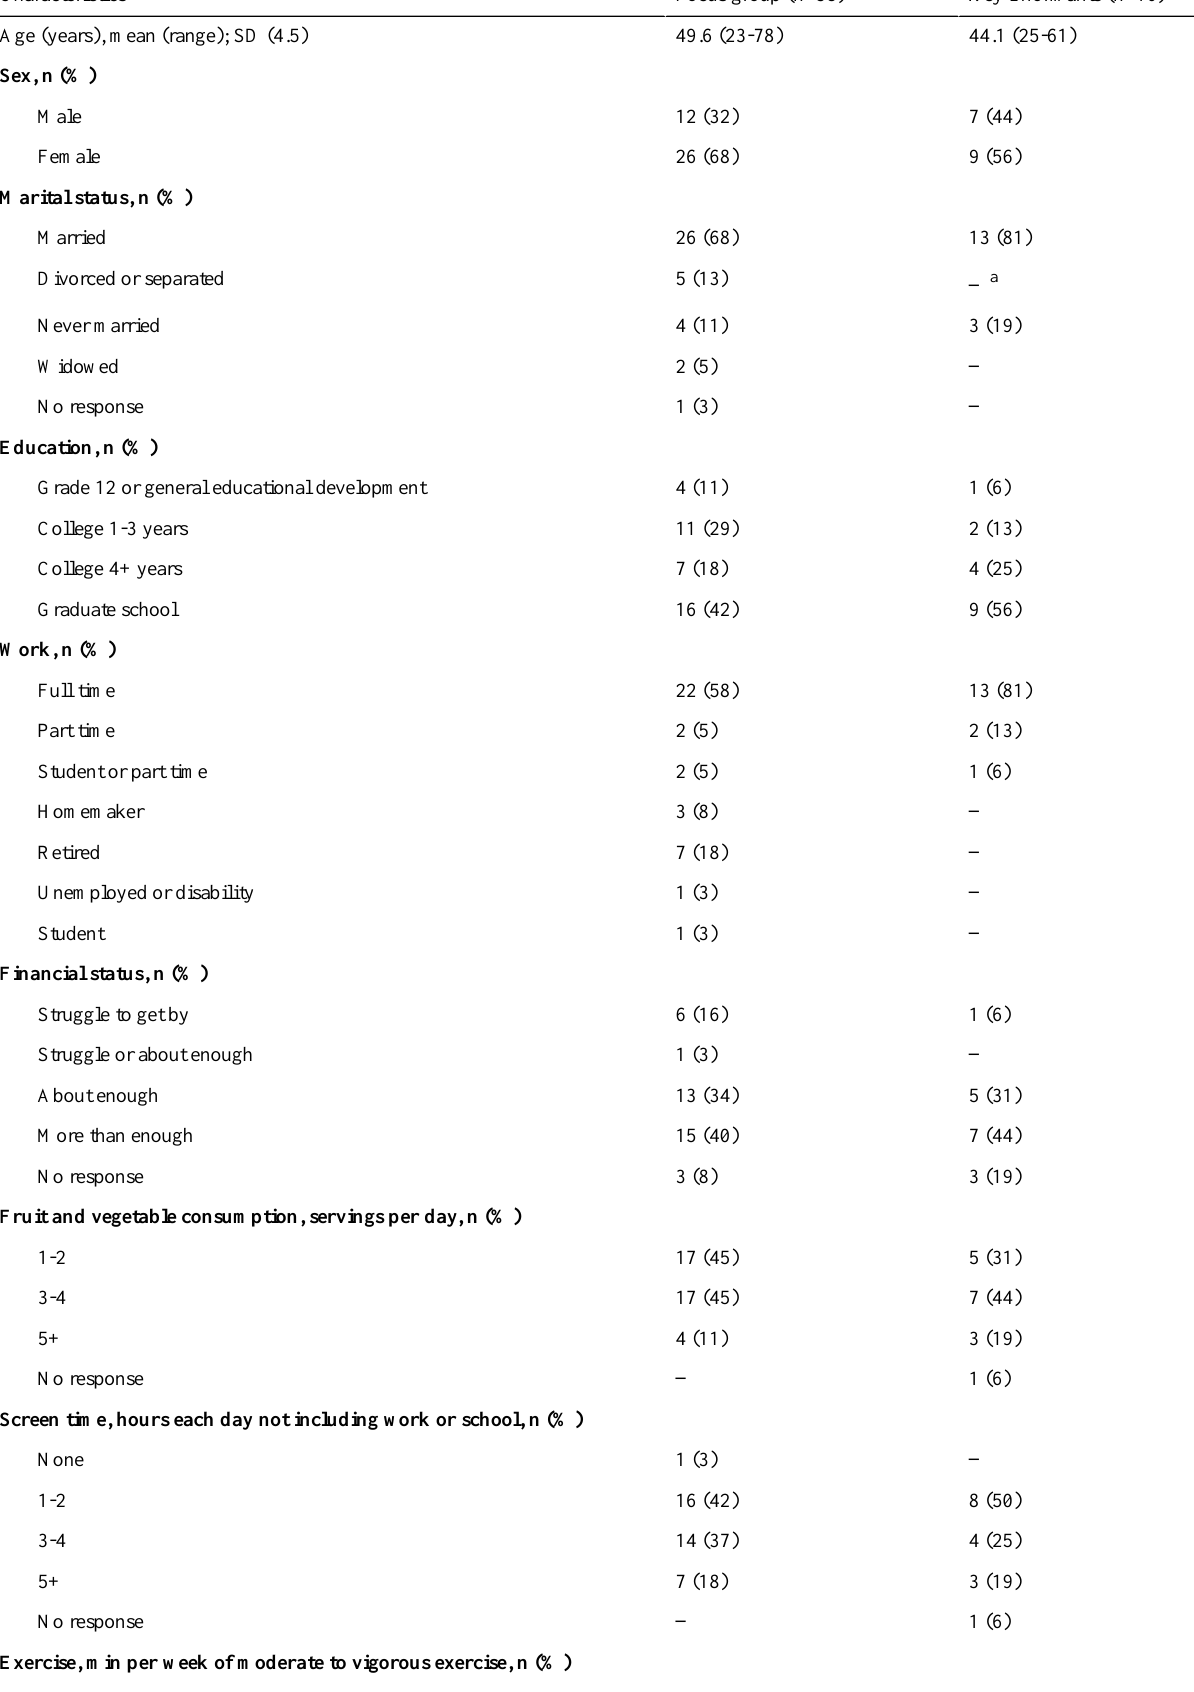
Key informants (n=16)Focus group